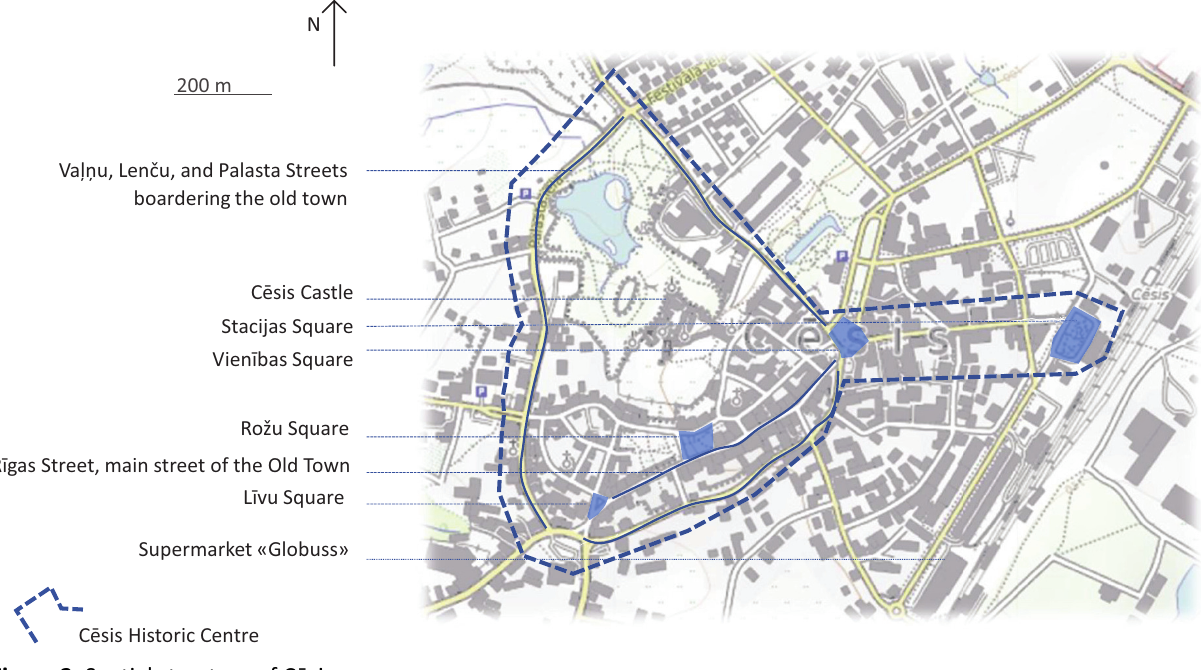
Figure 2. Spatial structure of